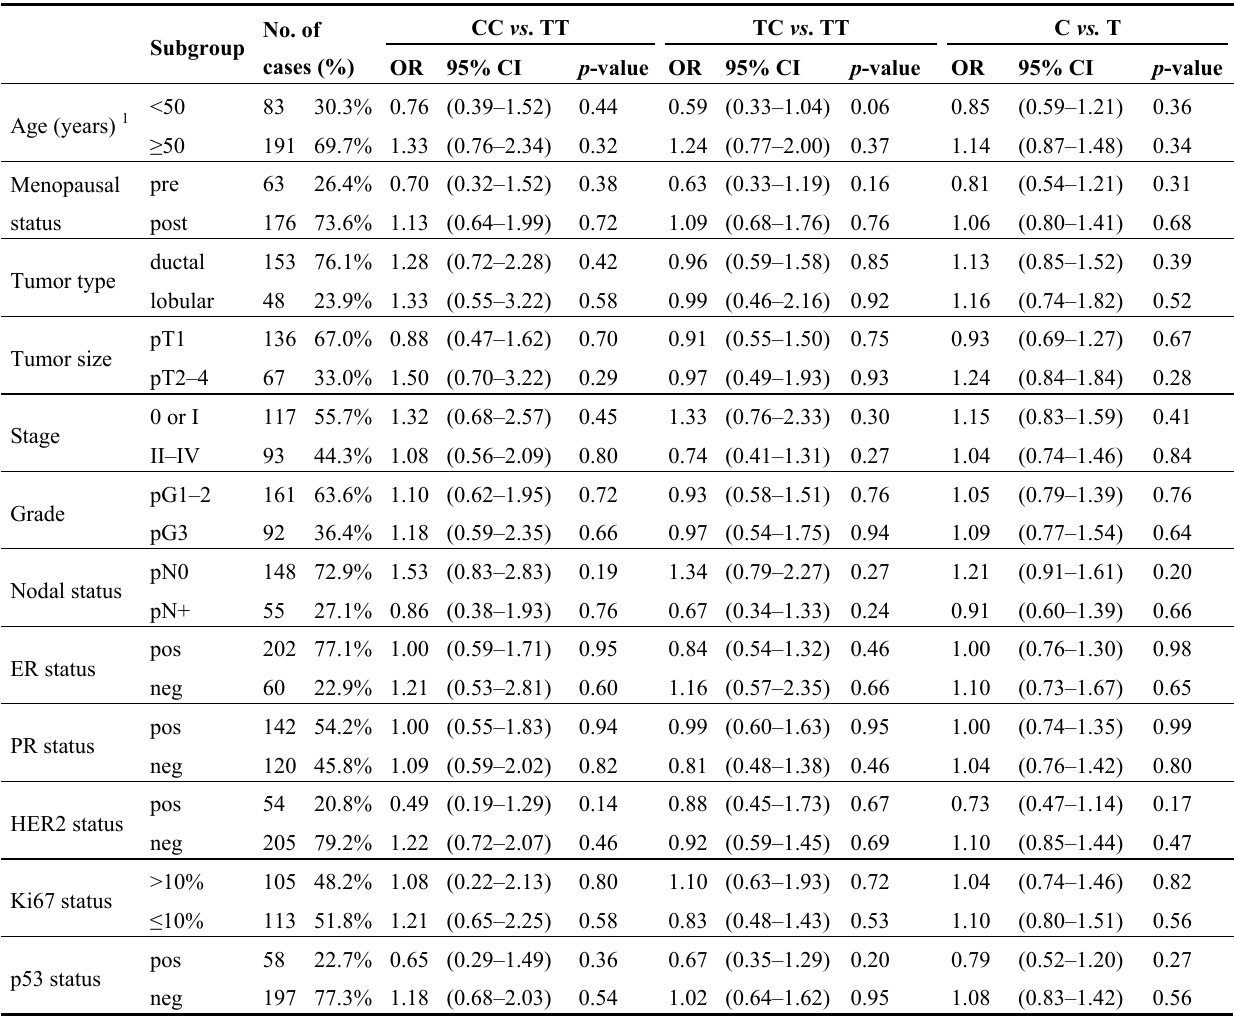
Table 3. Odds ratios, 95% confidence intervals and p -values for association of the CYP19 rs10046 polymorphism with breast cancer risk in the indicated patient subgroups.